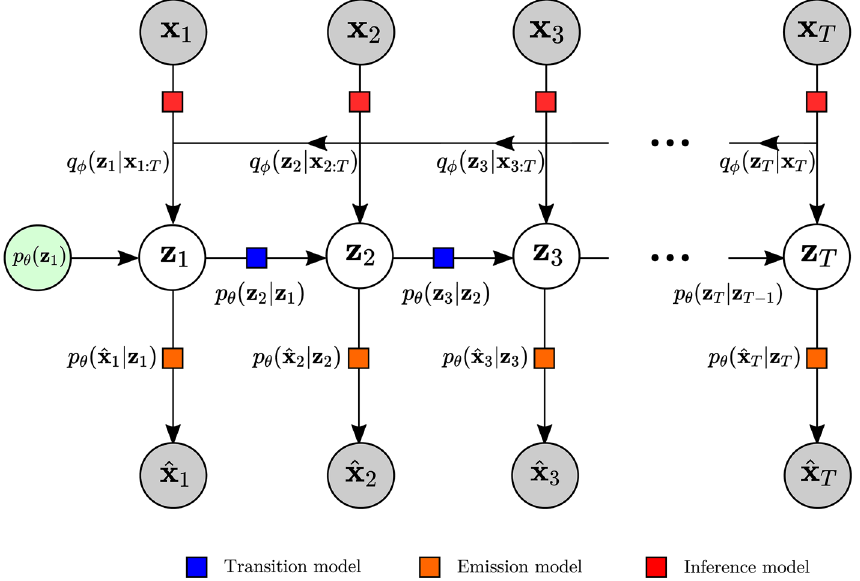
Figure 3. Deep Markov Model: Similarly to the VAE, the data is mapped to a latent representation of the data via the encoder. However, the final latent state is estimated as a weighted average between it’s previous and inferred state. For the first estimated state, the weighted average is computed with a learned prior distribution. This resulting latent state z t is the one that is passed on to the decoder transition and emission models for an estimation of the data and the subsequent latent